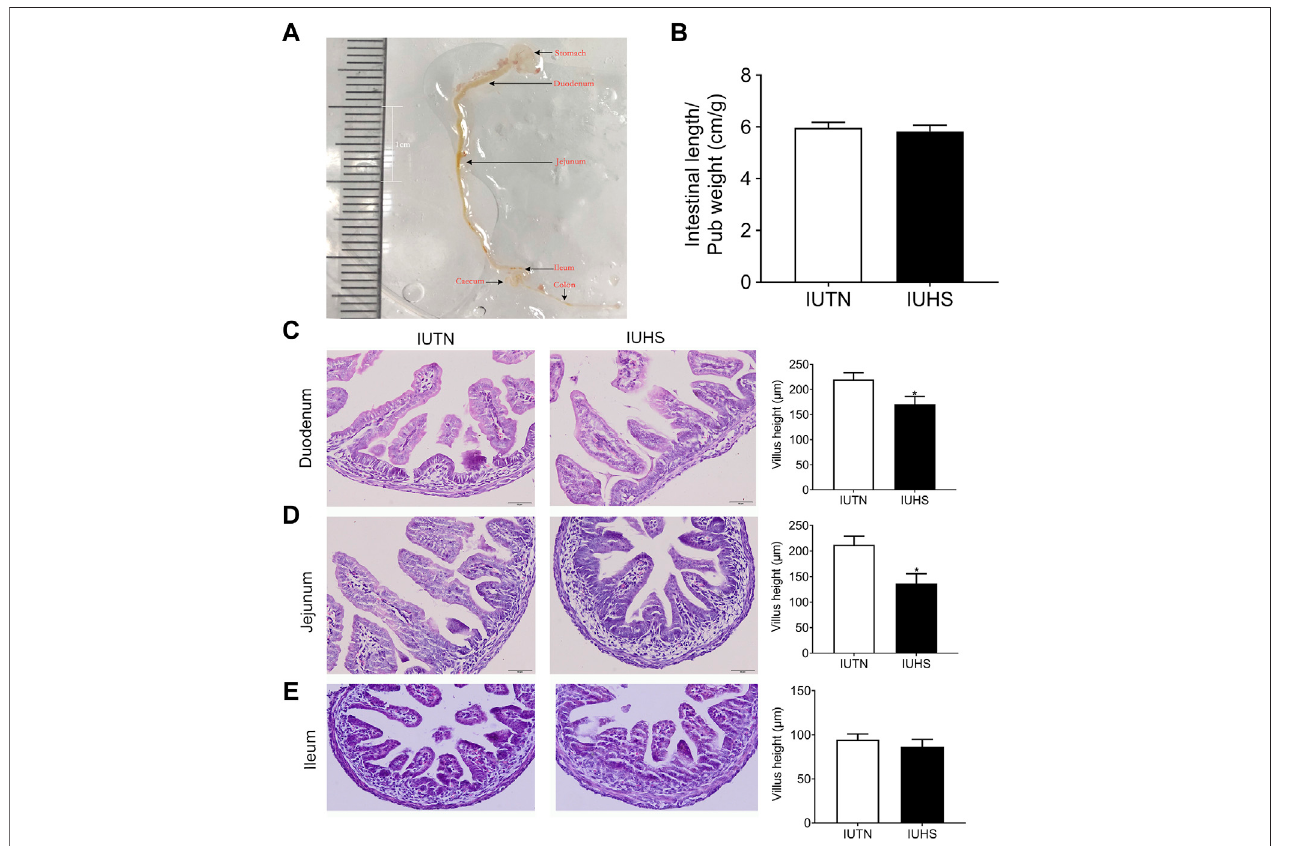
FIGURE 3 | Effects of maternal heat stress on the length and morphology of the fetal intestine. (A) Anatomical structure of the fetal intestine; (B) length of the fetal intestinenormalizedtopubweight(IUTN, n =11;IUHS, n =8); (C – E) HEhistology(left)andquanti fi cationofvillusheight(right)inthefetalduodenum (C) ,jejunum (D) ,and ileum (E) . IUTN: in utero TN group; IUHS: in utero HS group; n = 7. Scale bar: 100 μ M. Data are presented as mean ± SEM. * p < 0.05.